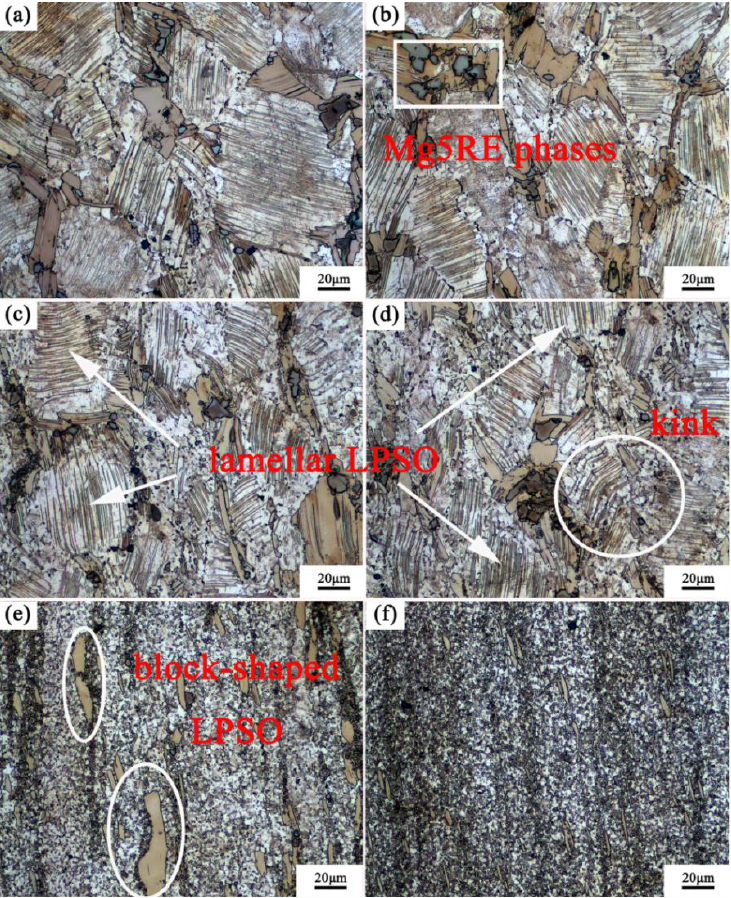
Figure 4. The OM images of the cross-section in the different zones along the RD, ( a ) region 6, ( b ) region 5, ( c ) region 4, ( d ) region 3, ( e ) region 2, ( f ) region 1.